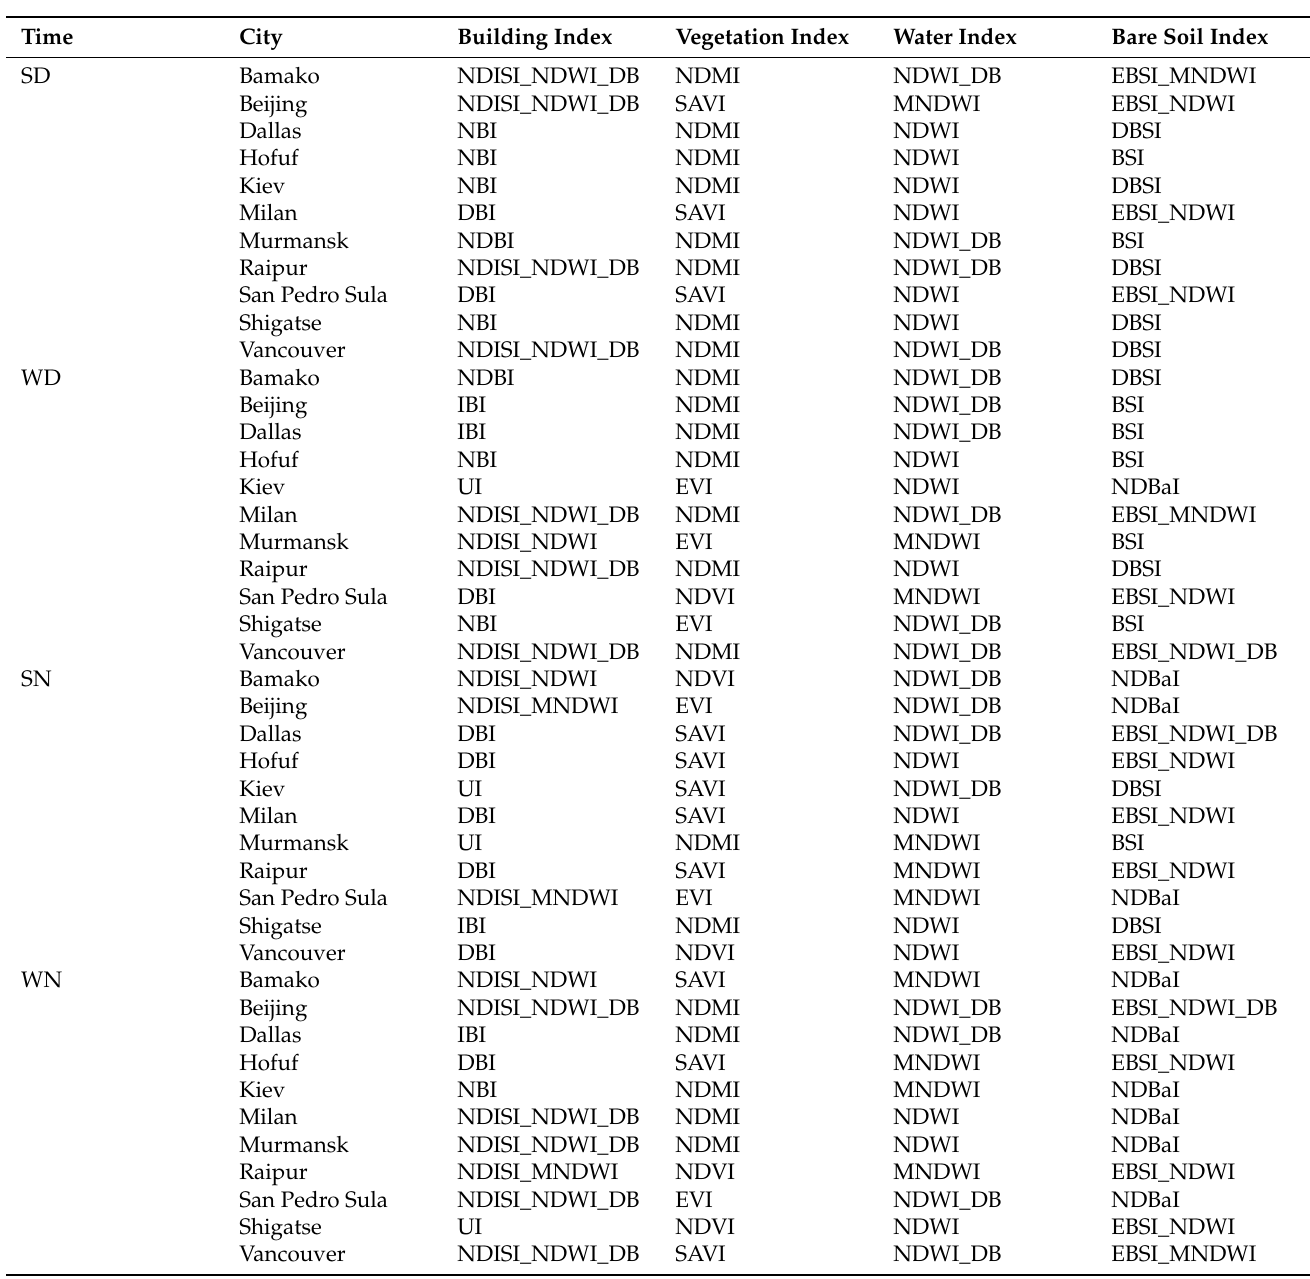
Table 4. The land-use/land-cover indices to show the largest correlation with the land surface temperatures during the daytime and nighttime in the summer and winter in the eleven selected cities in different global climatic